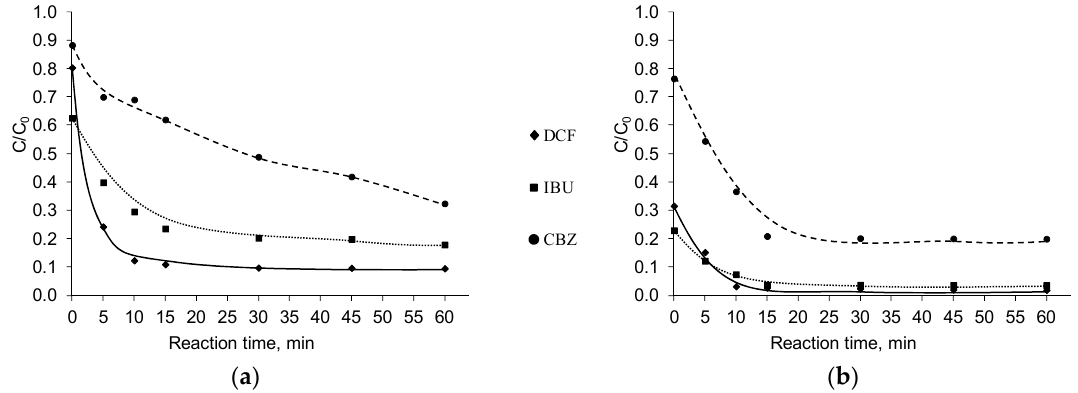
Figure 4. Degradation of pharmaceutical in ( a ) deionised water suspensions and ( b ) model WWTP effluent. Table 5. Reaction rate constant and half ‐ life of pharmaceutical compounds in the process of photocatalytic oxidation of the model effluent.